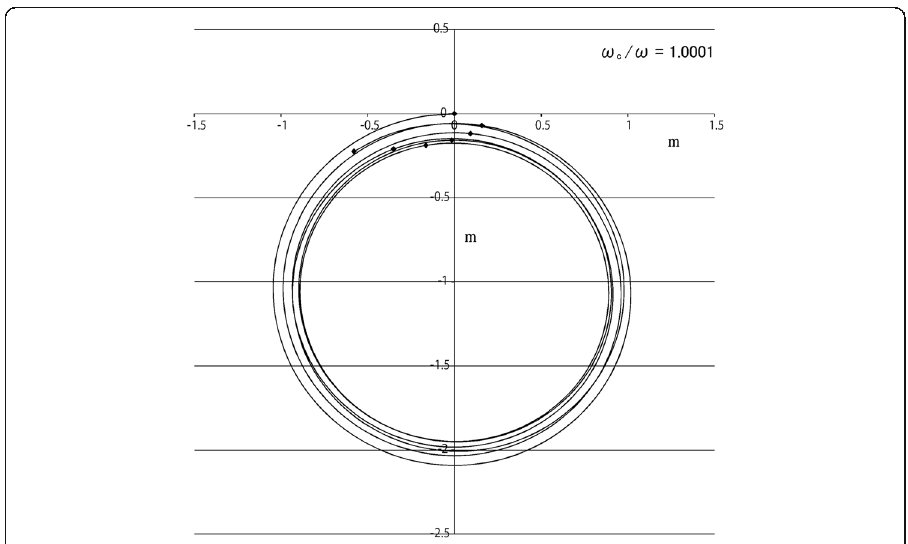
Fig. 4 The gyration orbit of a relativistic electron. The conditions are the same with in Fig. 3, except for the following change of the initial velocity at ( t =0): ^ z z 0 ¼ ^ z 10 8 → − ^ z 10 8 m/s. This figure is related with Fig.